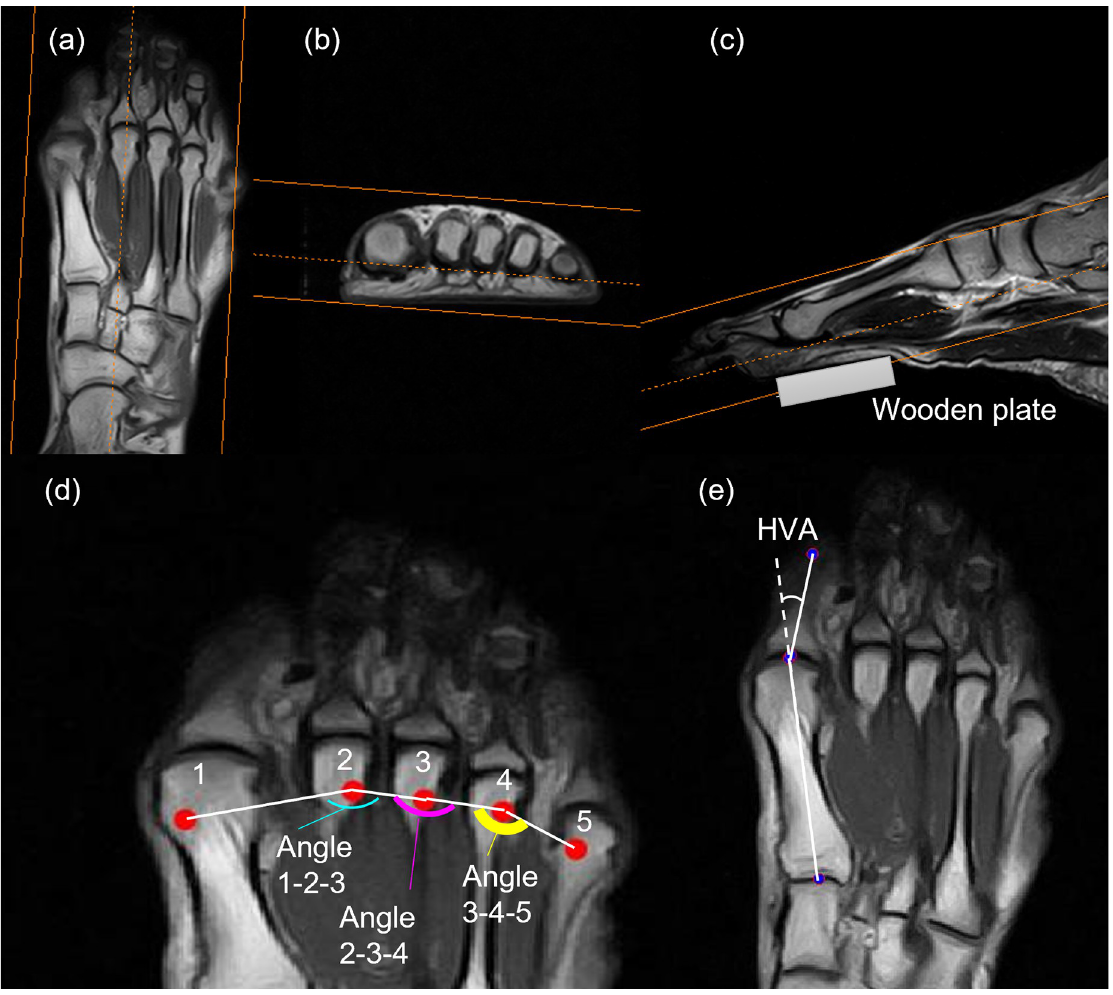
Fig 2. Magnetic resonance images and definitions of angles representing the alignment of a dancer’s metatarsal heads. (a-c) Views of the horizontal (a), frontal (b), and sagittal (c) images to determine the point on each metatarsal head closest to the sole. (d) Angles between adjacent metatarsal heads. The numbers indicate the first to fifth toes. The thin, medium, and thick arcs indicate angles 1-2-3, 2-3-4, and 3- 4-5, respectively. (c) Hallux valgus angle (HVA) determined using the method of Janssen et al.